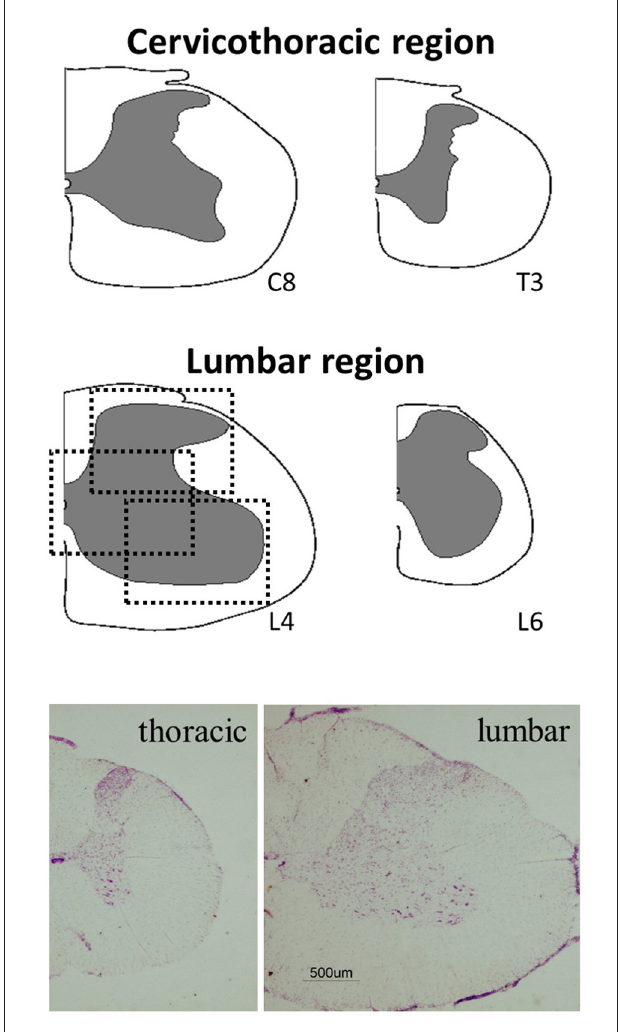
FIGURE 2 | Anatomical areas of interest considered for the analysis. Upper and middle panels show schematic representations of the different levels of the spinal cord considered, and dotted squares show an example of the analyzed fields for each coronal section: dorsal horn, central canal, and ventral horn. Lower panels show low-magnification half coronal sections at representative levels of the spinal cord stained with cresyl violet. Calibration bar: 500 µ m.